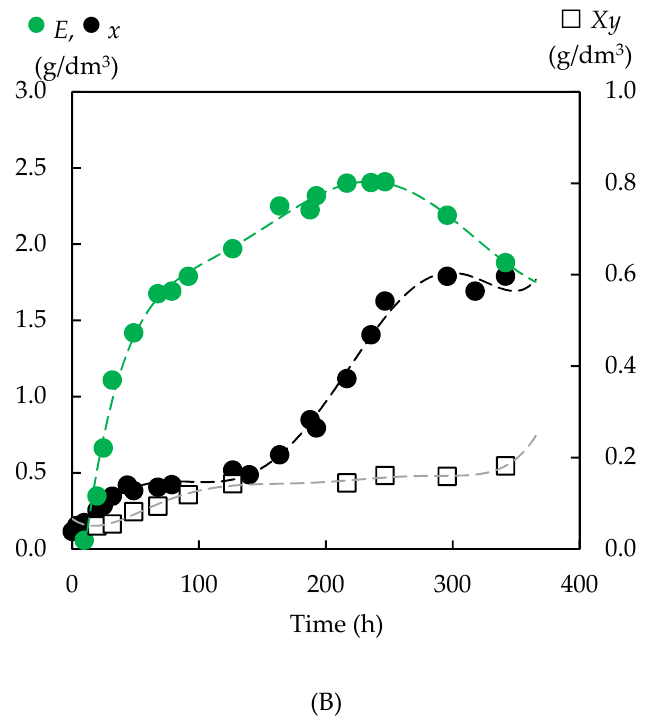
Figure 6. Fermentation with P. tannophilus of olive stones hydrolysates. Evolution over time of ( A ) substrates: total reducing sugars ( TRS ), D-glucose ( g ) and acetic acid ( AA ); and ( B ) bioproducts: ethanol ( E ), biomass ( x ) and xylitol ( Xy ).